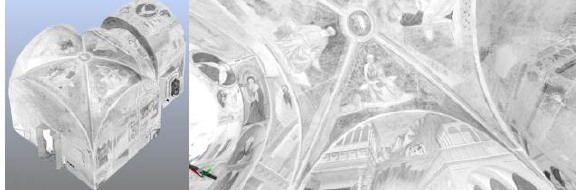
Figura 3: Laser scans of the interior space of Baptistery (grey scale